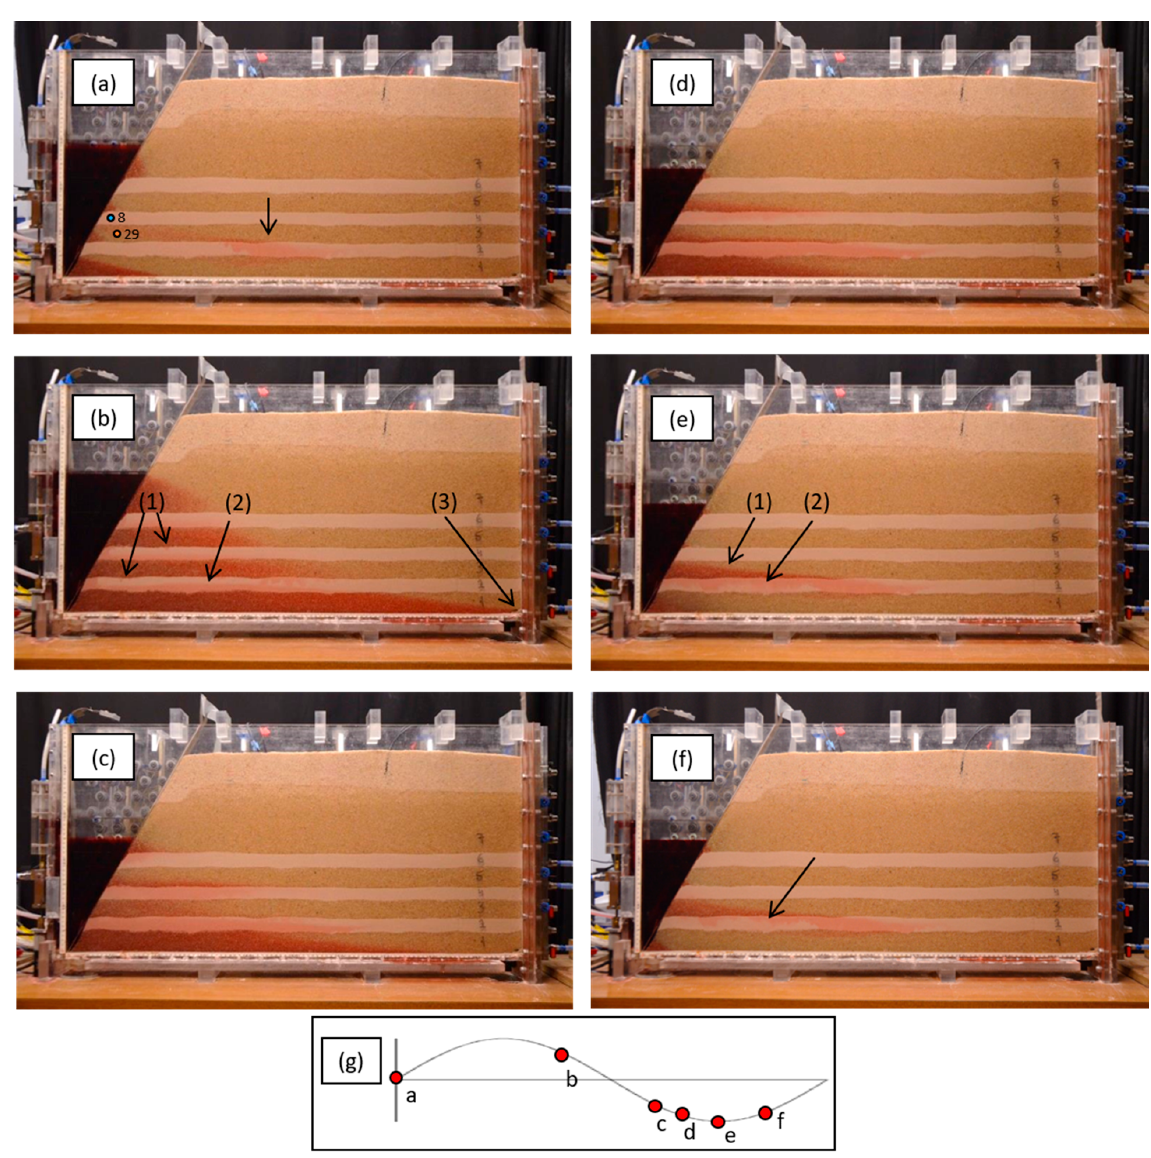
Figure 4. A tidal cycle in E3-180. Several phenomena are depicted, including a remaining saline pocket ( a ); salt fingers ( b1 ); flat salt front ( b2 ); maximum FSI’s toe intrusion ( b3 ); saltwater drainage horizontally from the aquifers ( c ); flooding from vertical saltwater again ( d , e1 ); and flushing fingers ( e2 , f ). Step timing is described in the schematic graph below ( g ).